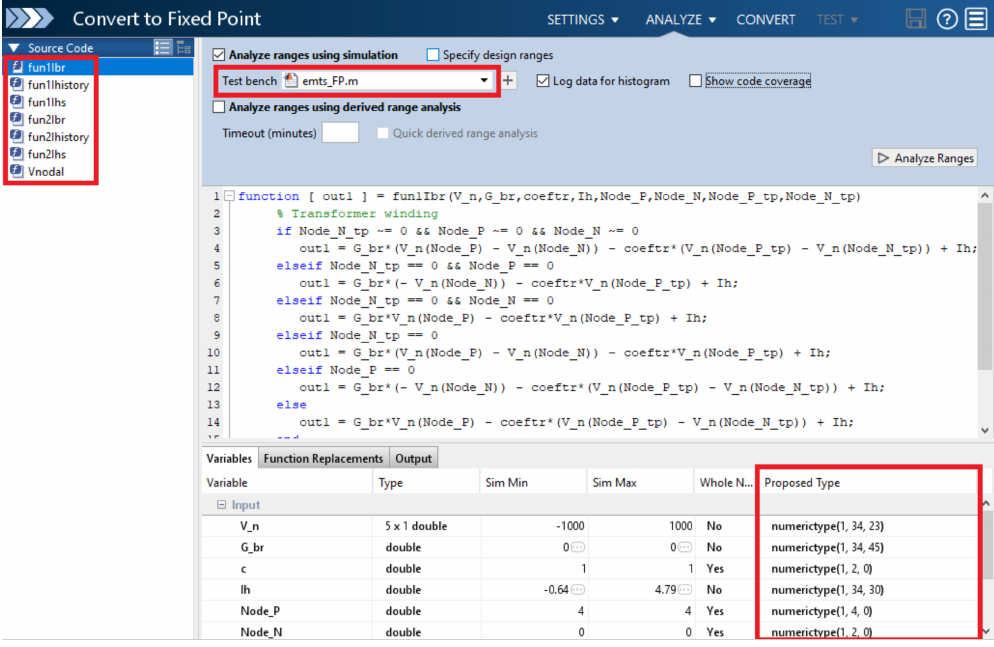
Figure 18. Fixed-Point analysis